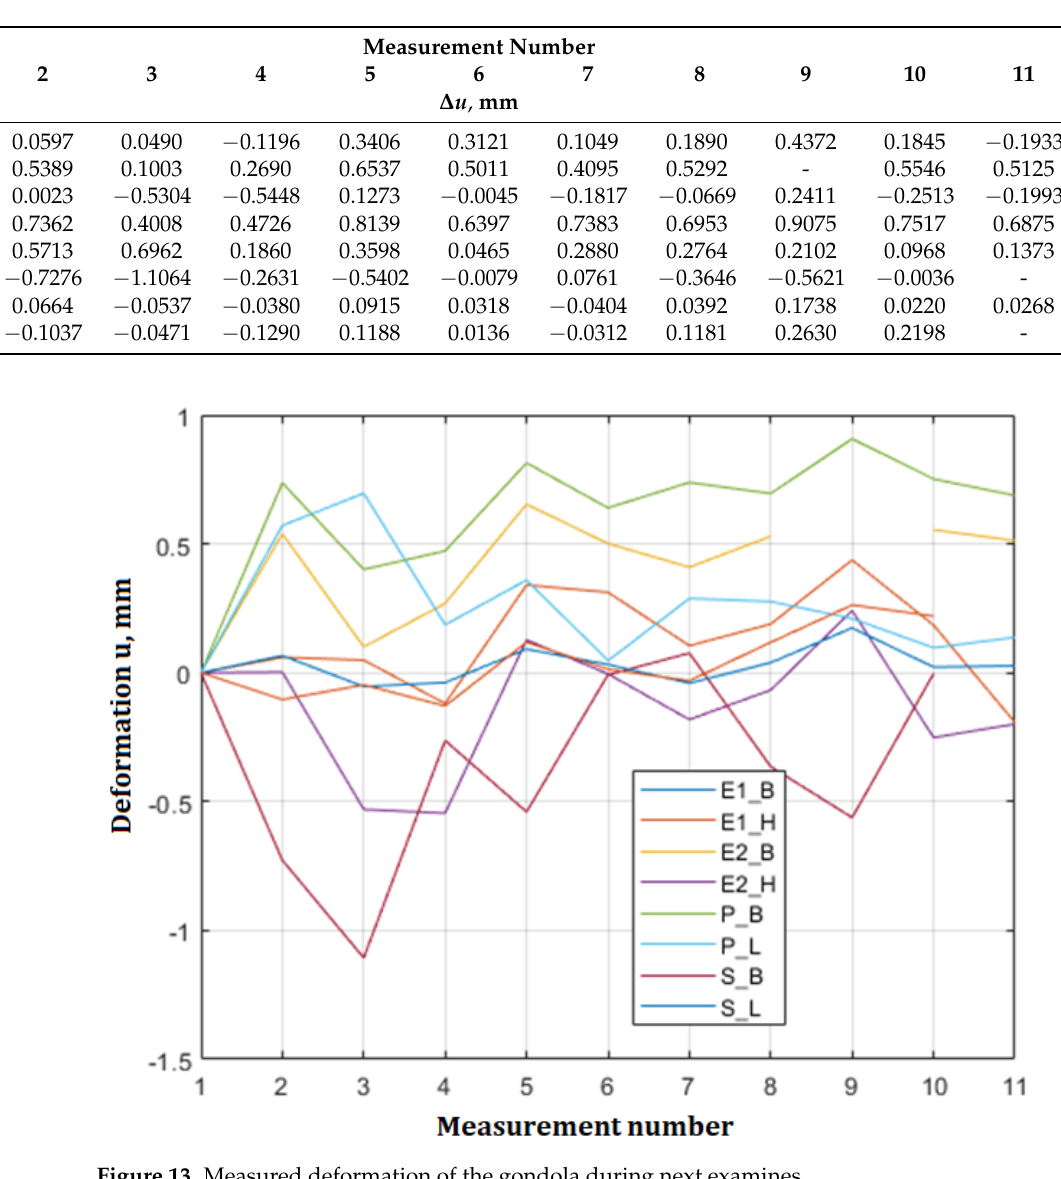
Figure 13. Measured deformation of the gondola during next